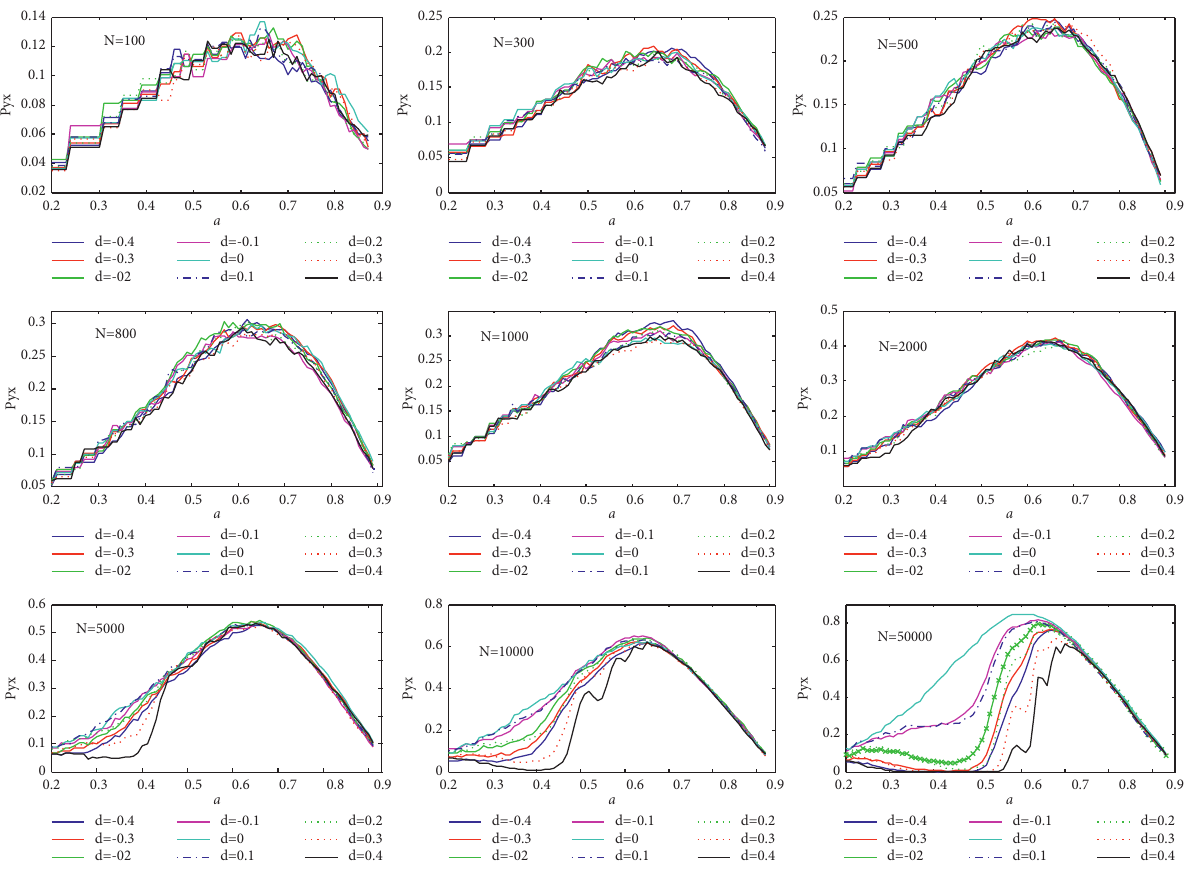
Figure 6: Estimation accuracy of the long memory parameter.